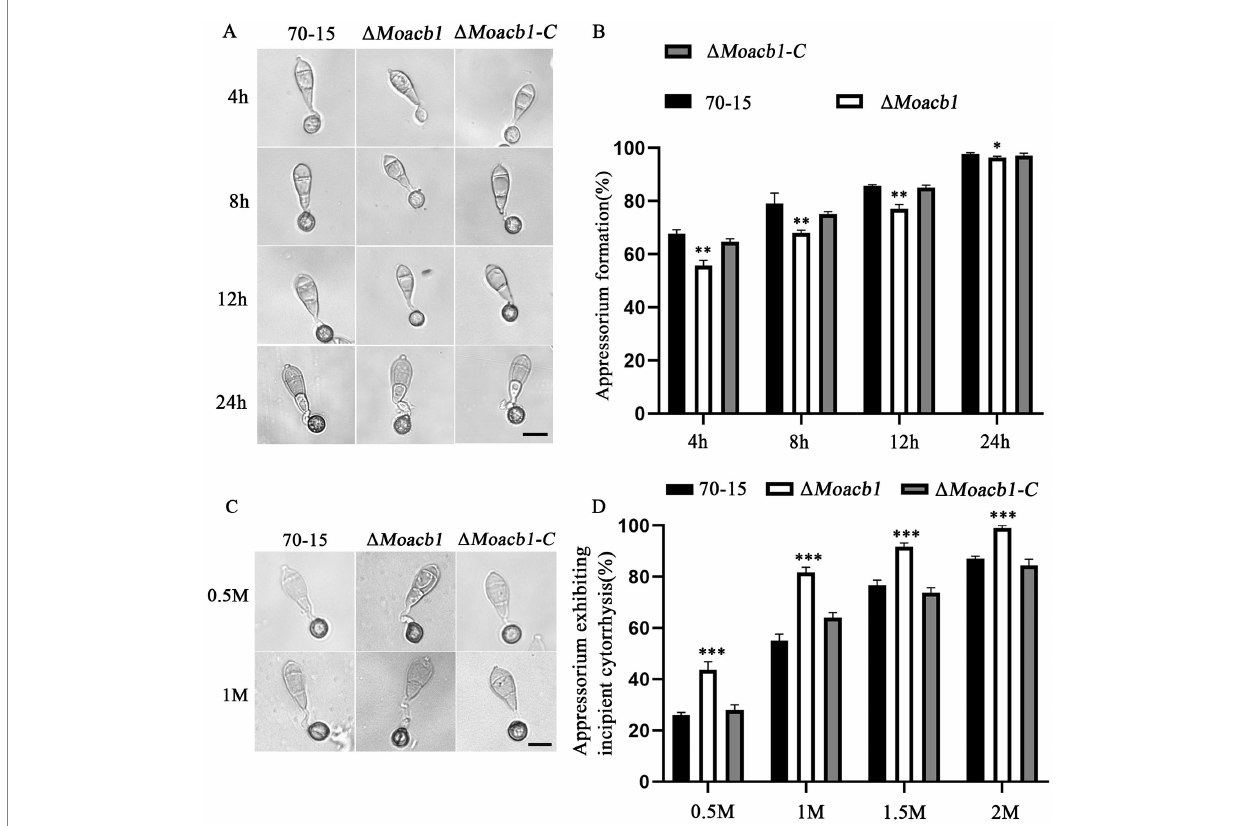
FIGURE 3 MoAcb1 is important for appressorium formation. (A) The conidial suspensions of the 70-15, ∆ Moacb1 and ∆ Moacb1-C strains were inoculated on the hydrophobic surface to photograph appressorium formation at different times. Bar, 20 μ m. (B) The formation rate of the appressorium was calculated and statistically analyzed, with the standard deviation indicated by error bars. T -test was used to test for significant differences. * p < 0.05, ** p < 0.01. (C) Cell collapse of the 70-15, ∆ Moacb1 and ∆ Moacb1-C strains in different concentrations of glycerol. Bar, 20 μ m. (D) Cell collapse rates were calculated and statistically analyzed, with the standard deviation indicated by error bars. T -test test was used to test for significant differences. *** p <